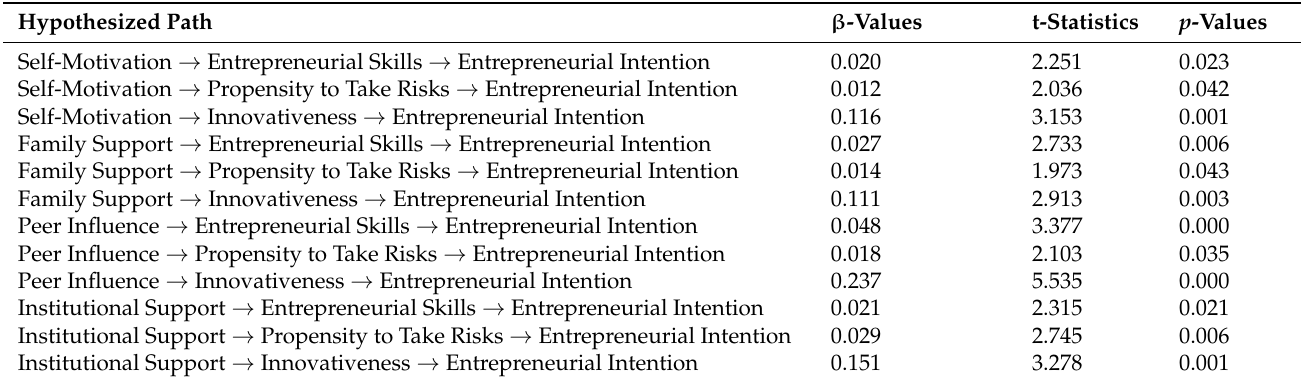
Table 5. Indirect